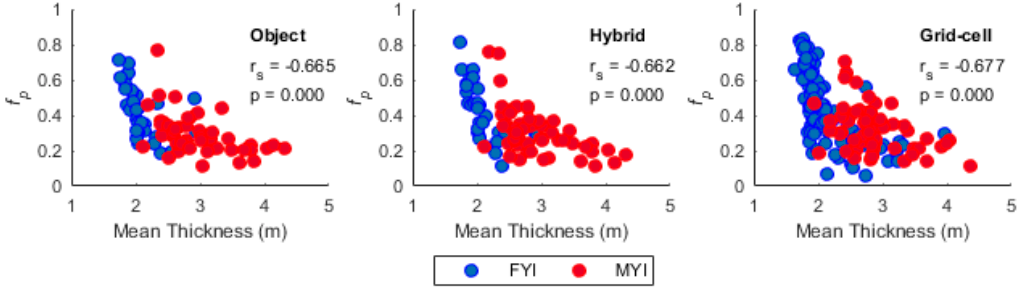
Figure 7. Scatter plots of f p as a function of mean thickness at the medium scale using object ( left ), hybrid object ( middle ) and 240 m grid-cell ( right ) aggregation approaches. Spearman correlation coefficients (r s ) and corresponding p -values are shown for pooled FYI and MYI data.